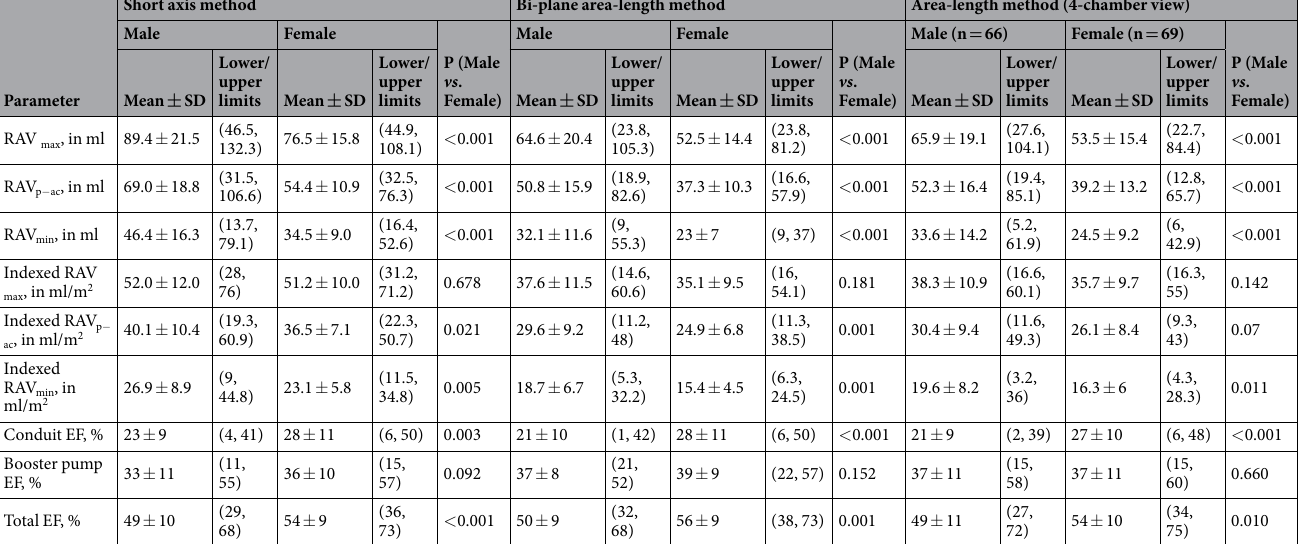
Table 7. Gender specific reference values of the RA volume and phasic function assessed by the short axis or area–length method (n = 135). Lower/upper limits calculated as mean ± 2 SD; RAV max , maximal right atrial volume; RAV p − ac , right atrial volume before atrial contraction; RAV min , minimal right atrial volume; Indexed volumes are calculated by the corresponding volume in mL divided by BSA in m 2 ; Conduit EF, Conduit right atrial emptying fraction: 100% × (RAV max − RAV p − ac )/RAV max ; Booster pump EF, Booster pump right atrial emptying fraction: 100% × (RAV p − ac − RAV min )/RAV p − ac ; Total EF, total right atrial emptying fraction: 100% × (RAV max − RAV min )/RAV max